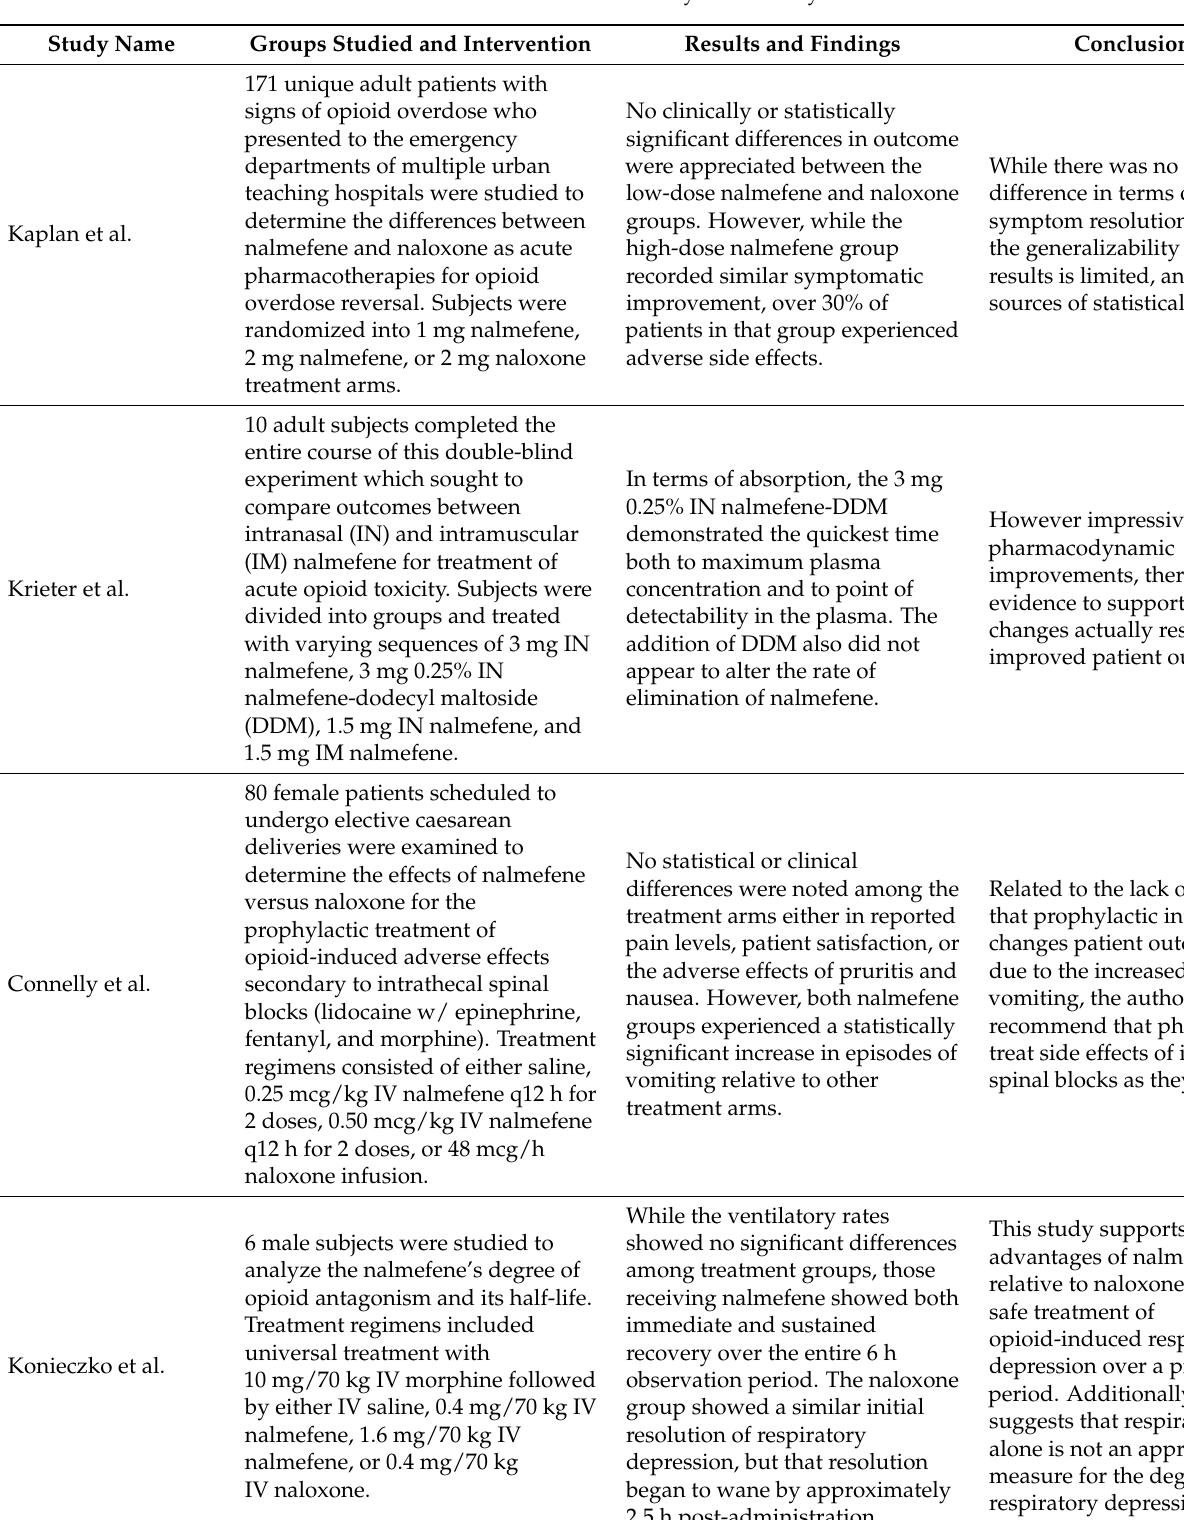
Table 2. Clinical safety and